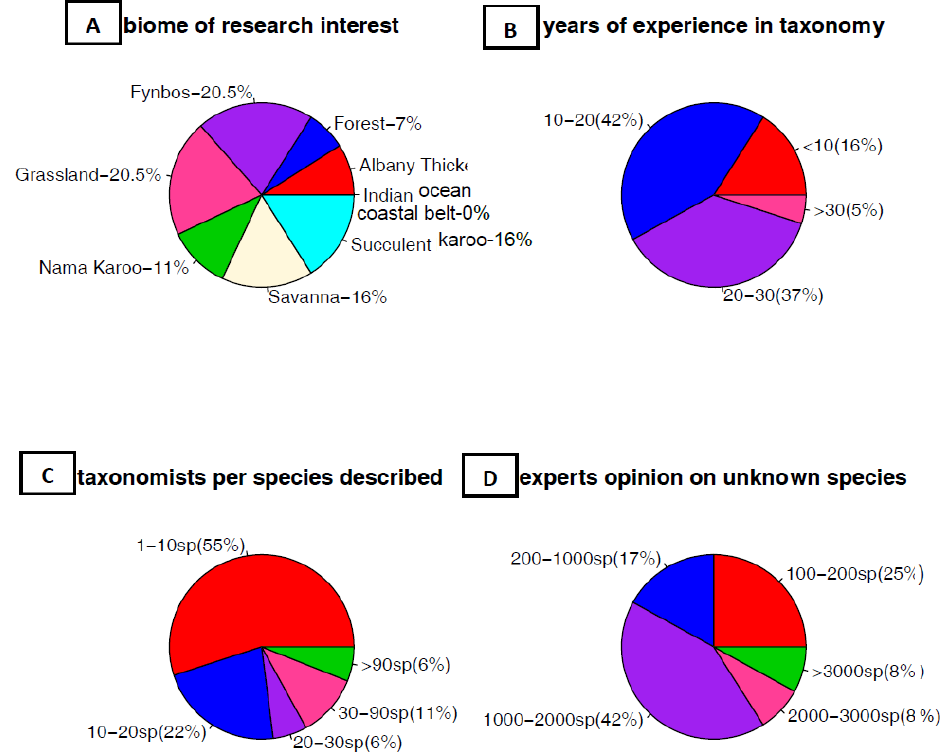
Figure 4. Summary of taxonomic activities of plant experts in South Africa.